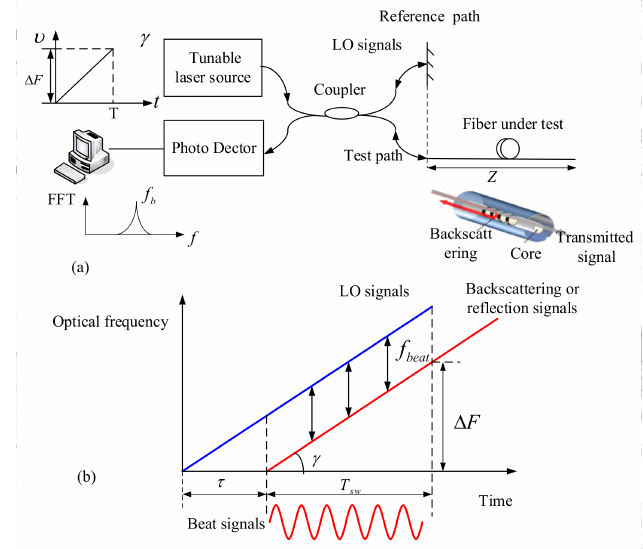
Figure 1. ( a ) OFDR basic configuration and ( b ) linearly tuning optical frequency and beating signals come from the LO light and received